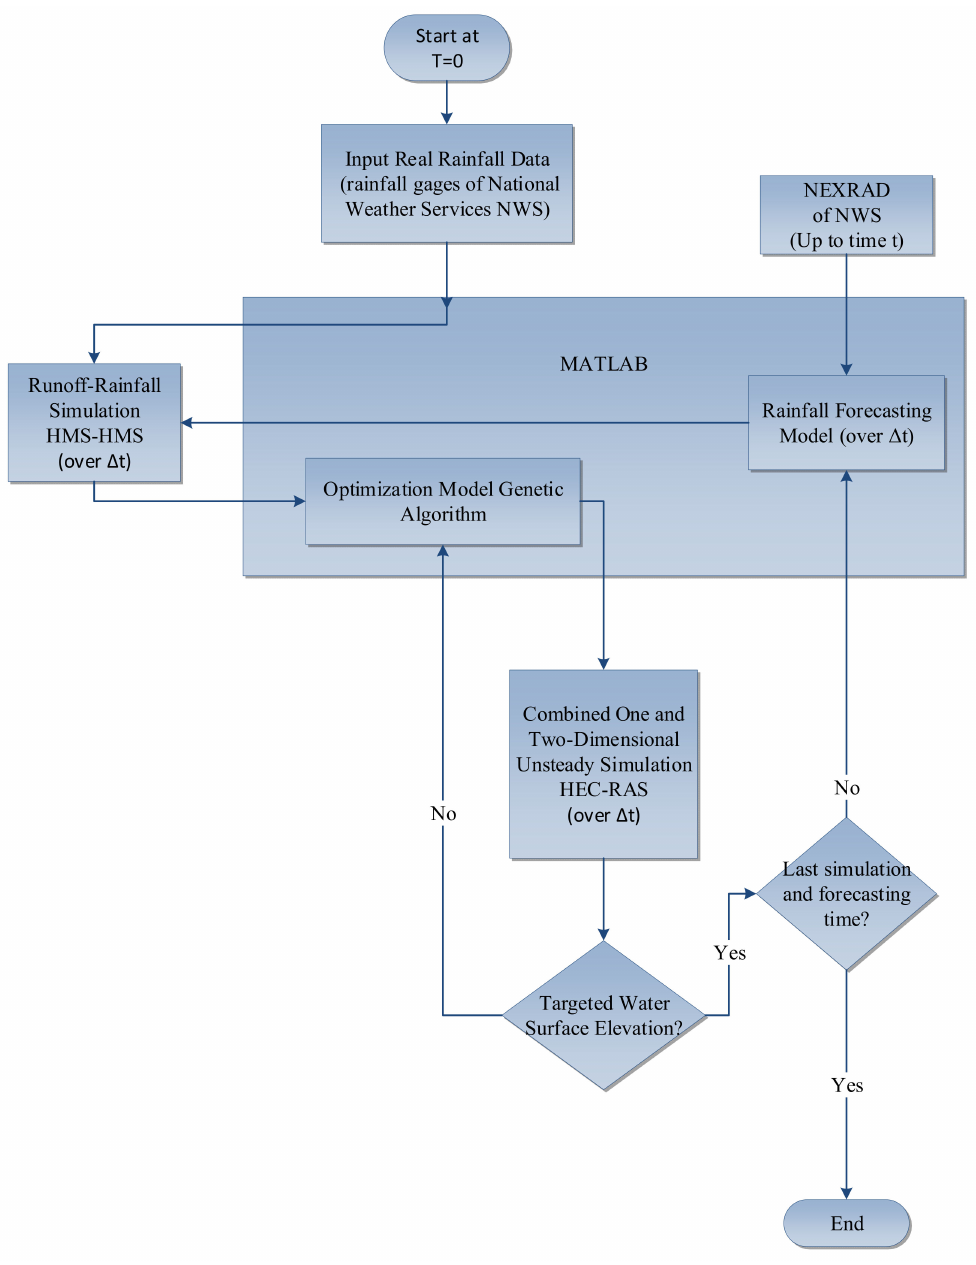
Figure 2. Modeling